Question: Give a one-sentence summary of this figure.
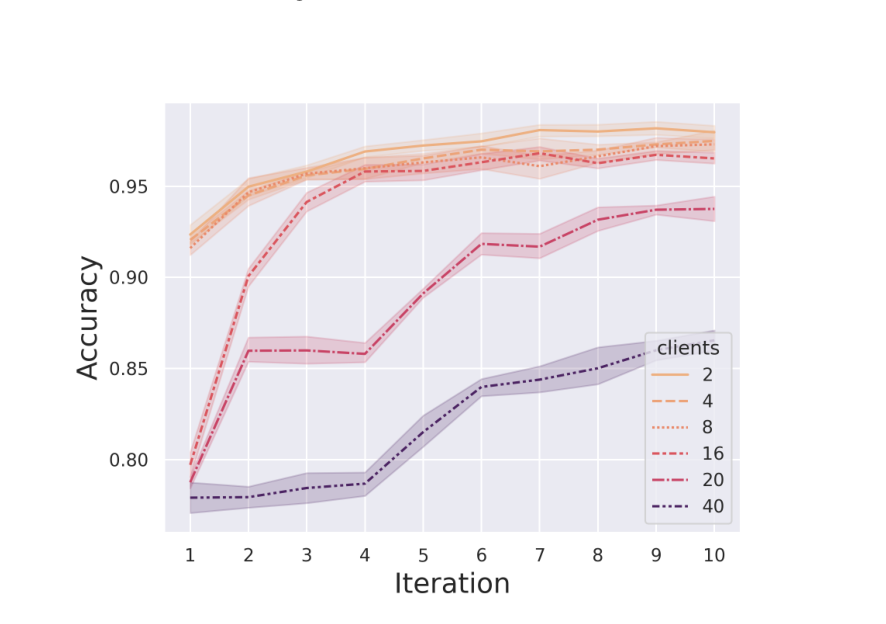
Answer: Test accuracy for various number of clients. Accuracy is shown with significant intervals, averaged over 5 runs.